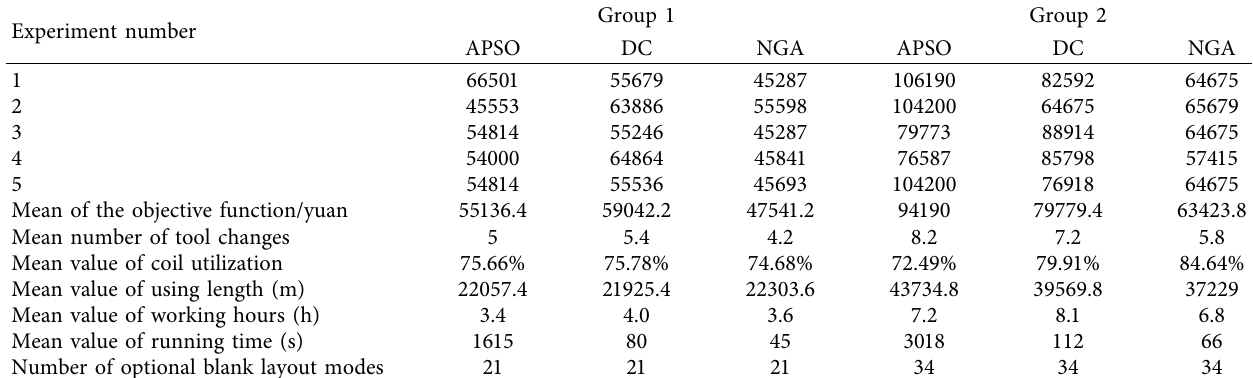
Table 3: Blanking